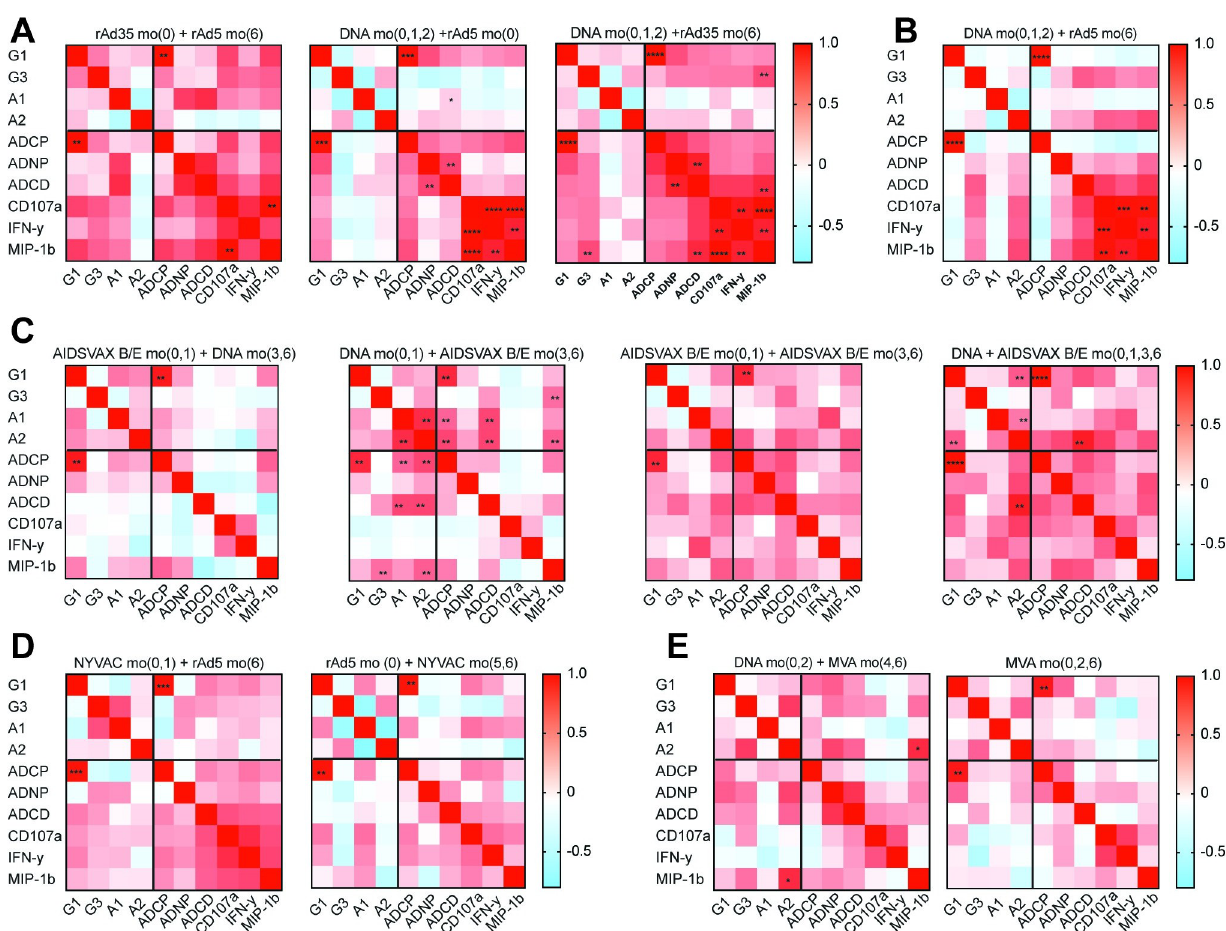
Fig 3. Subclass/isotype functional coordination varies by regimen/vaccine strategy. The heatmaps show Spearman correlations across antibody functional measurements and subclass/isotype levels for: A: 077 trials, with each heatmap depicting a different trial arm, left to right: T1, T2, T3; B: the DNA and rAd5 trial 204; C: the DNA/AIDSVAX B/E trial 105, trial arms T1 to T4; D: Trial 078 NYVAC/rAd5 (T1 and T2 arms); E: Trial 205 using DNA/ MVA (T3 and T4). Red depicts high positive correlation coefficients, whereas blue displays a negative correlation, P values were Bonferroni corrected for multiple comparisons, � p < 0.05, �� p < 0.01, ��� p < 0.001, ���� p < 0.0001.